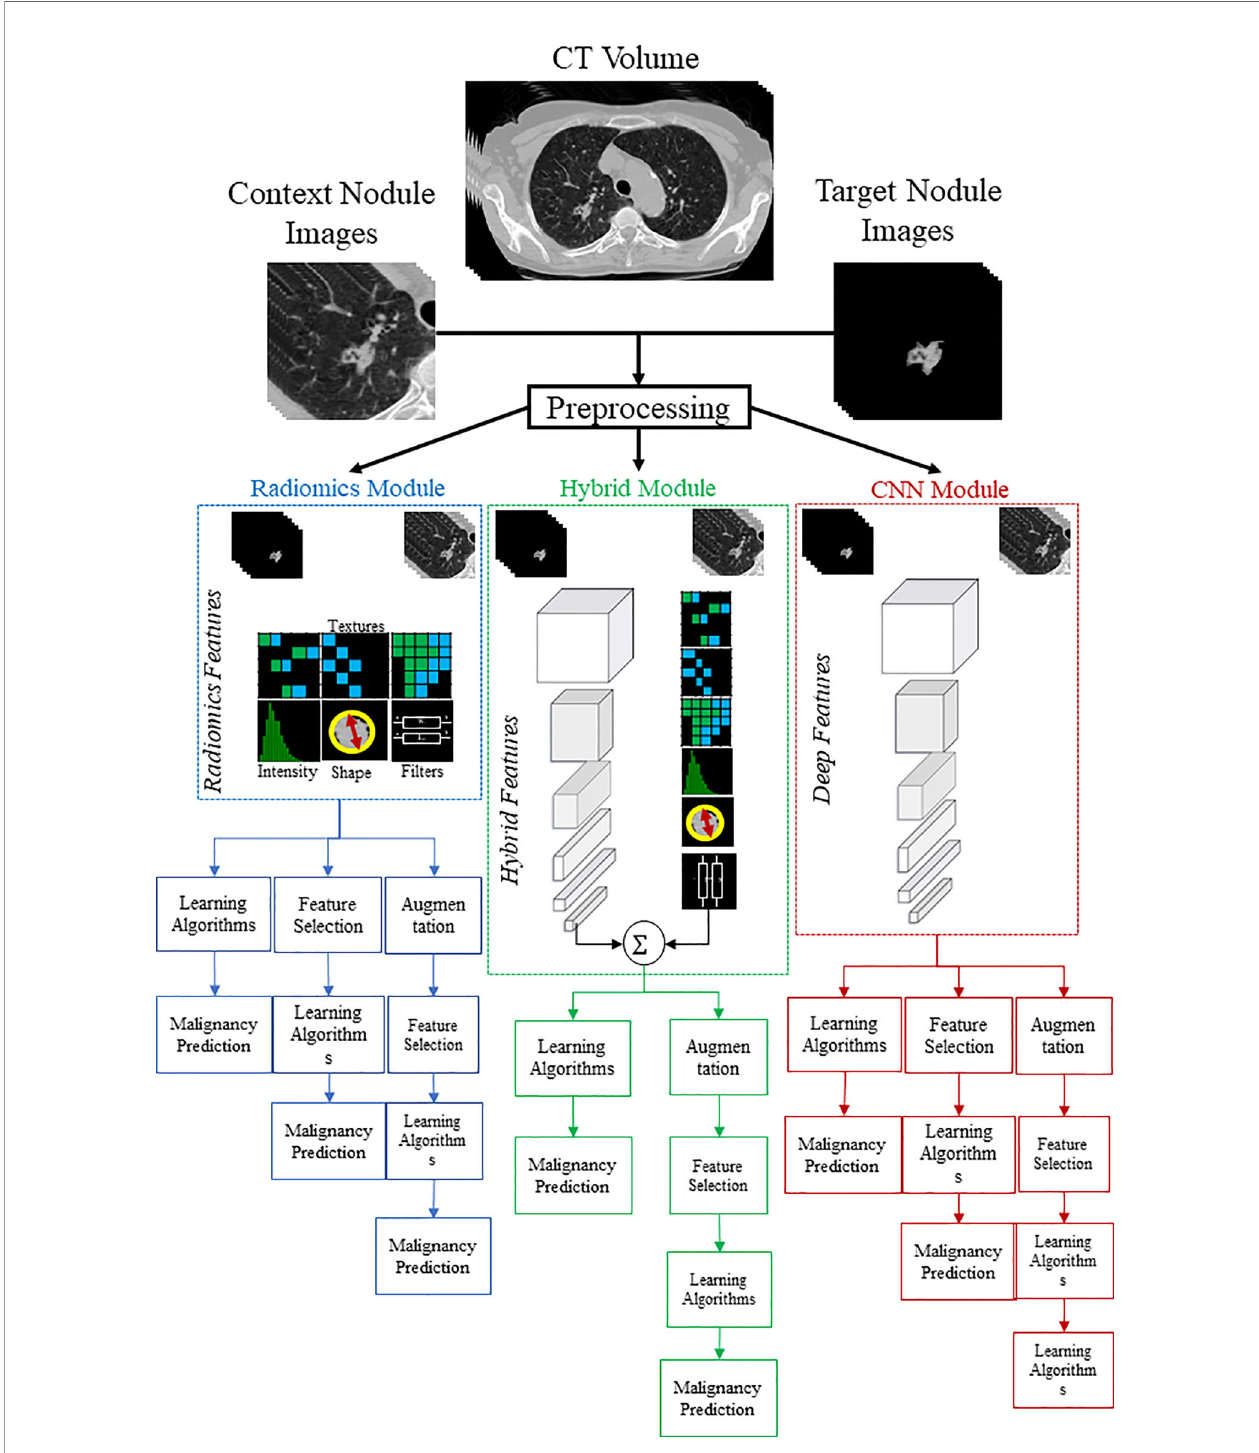
FIGURE 2 | Graphical demonstration of the study pipeline. To predict lung nodule malignancy, three modules were studied. In the CNN module (red color), deep networks were trained with context and target nodule images separately and simultaneously. In the Radiomics module (blue color), handcrafted features were extracted from both target and context nodule images to train the learning algorithms. In the hybrid module (green color), extracted radiomic features were combined with learned deep features to form the hybrid sets.